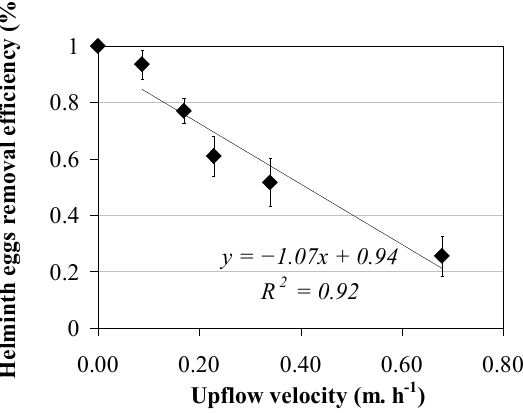
Figure 2. Helminth egg removal efficiencies ( ♦ ) versus upflow velocity at a sludge bed height between 0.30 and 0.40 m.